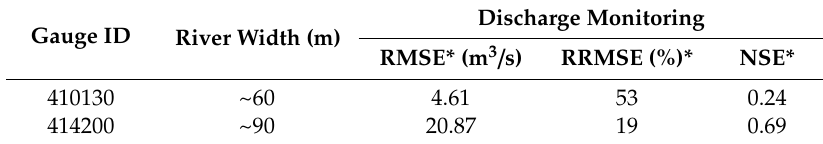
Table 2. Accuracy of discharge estimation for two test gauges in validation